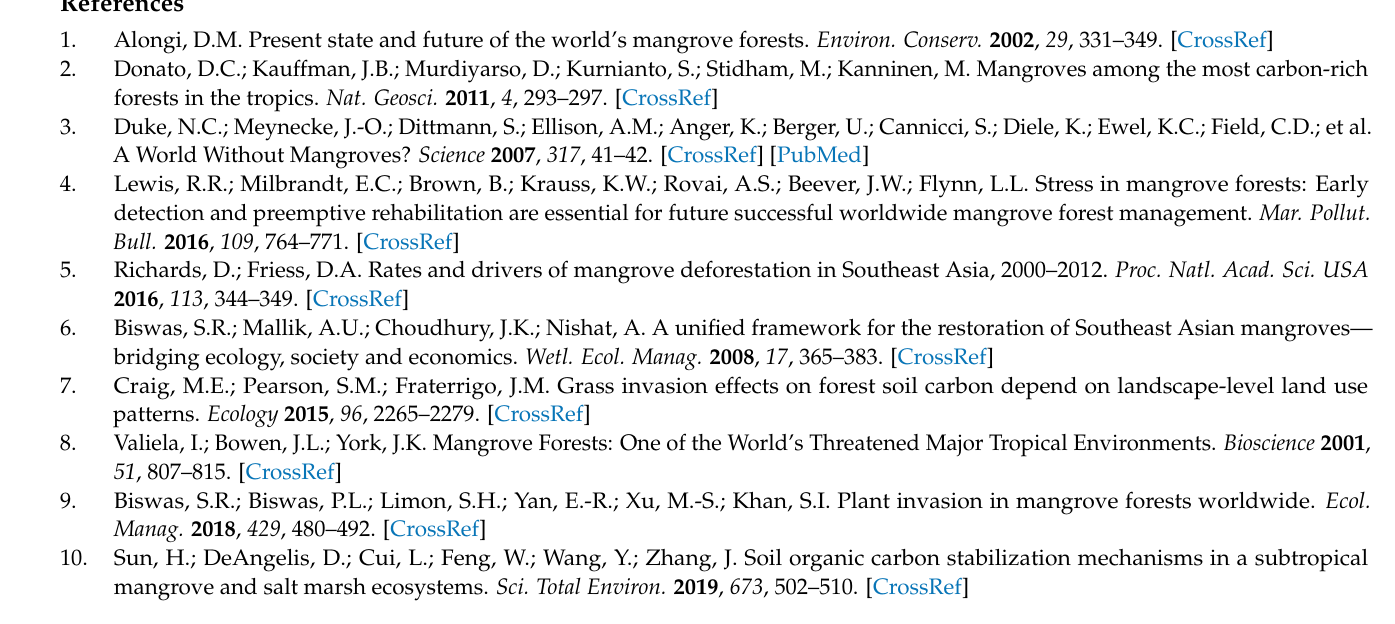
Table S9: Results of PerMANOVA test in fungal function composition among the SC, TC and MC communities. Table S10: The barcode information corresponding to samples’ information. Figure S1: Results of PCoA showing the first two principal coordinates that, combined, explain 70.78% and 30.97% of the observed variation in bacterial (a) and fungal (b) functional structure. The shapes of up triangle and square on the figure legend correspond to the soil layer of 0–15 cm and 15–30 cm, and the colors of red, green and yellow correspond to the SC, TC and MC communities, respectively (PerMANOVA test, p <